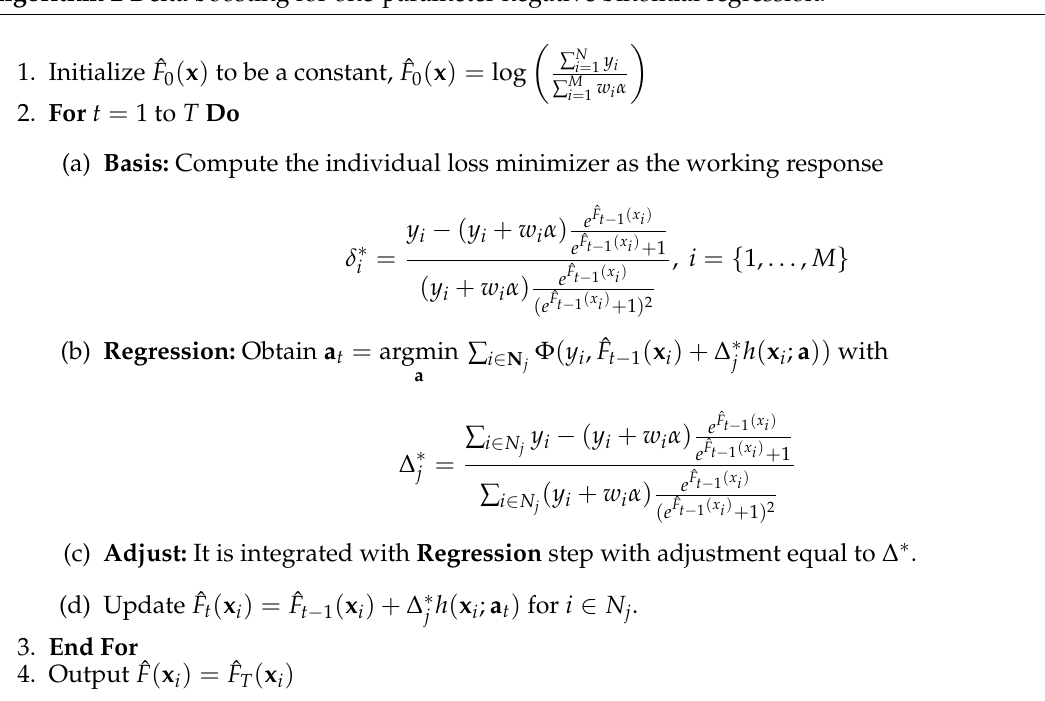
Algorithm 2 Delta boosting for one-parameter negative binomial